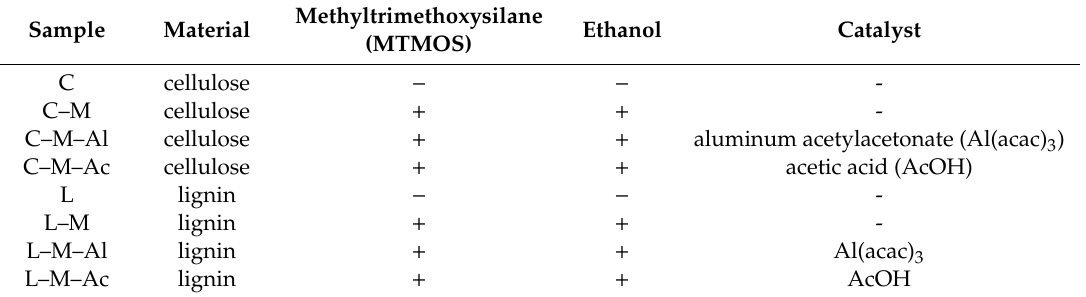
Table 1. Content of reaction